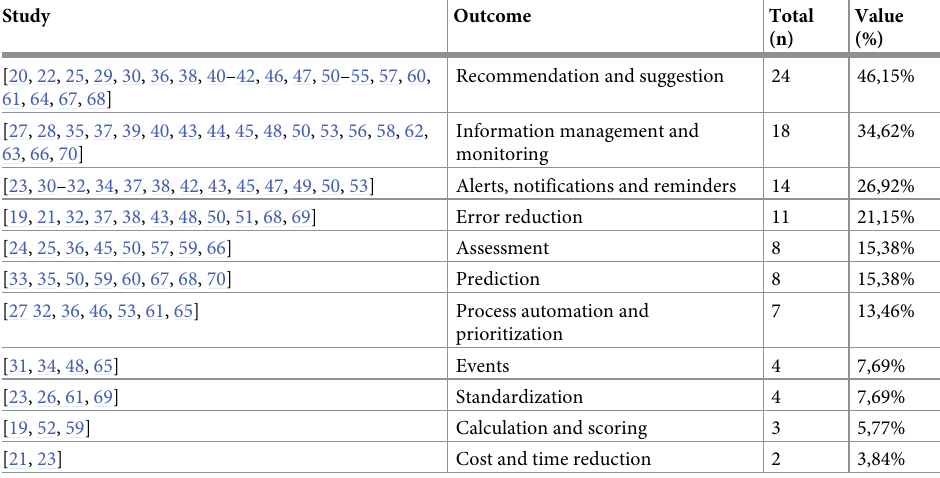
Table 4. Outcomes of technological features.